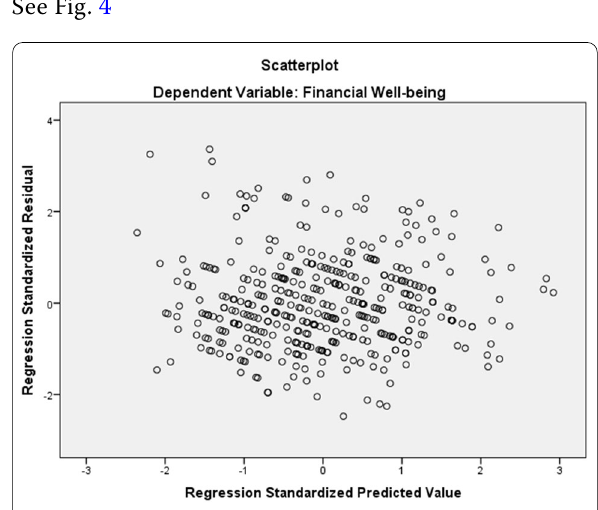
Fig. 4 Homoscedasticity